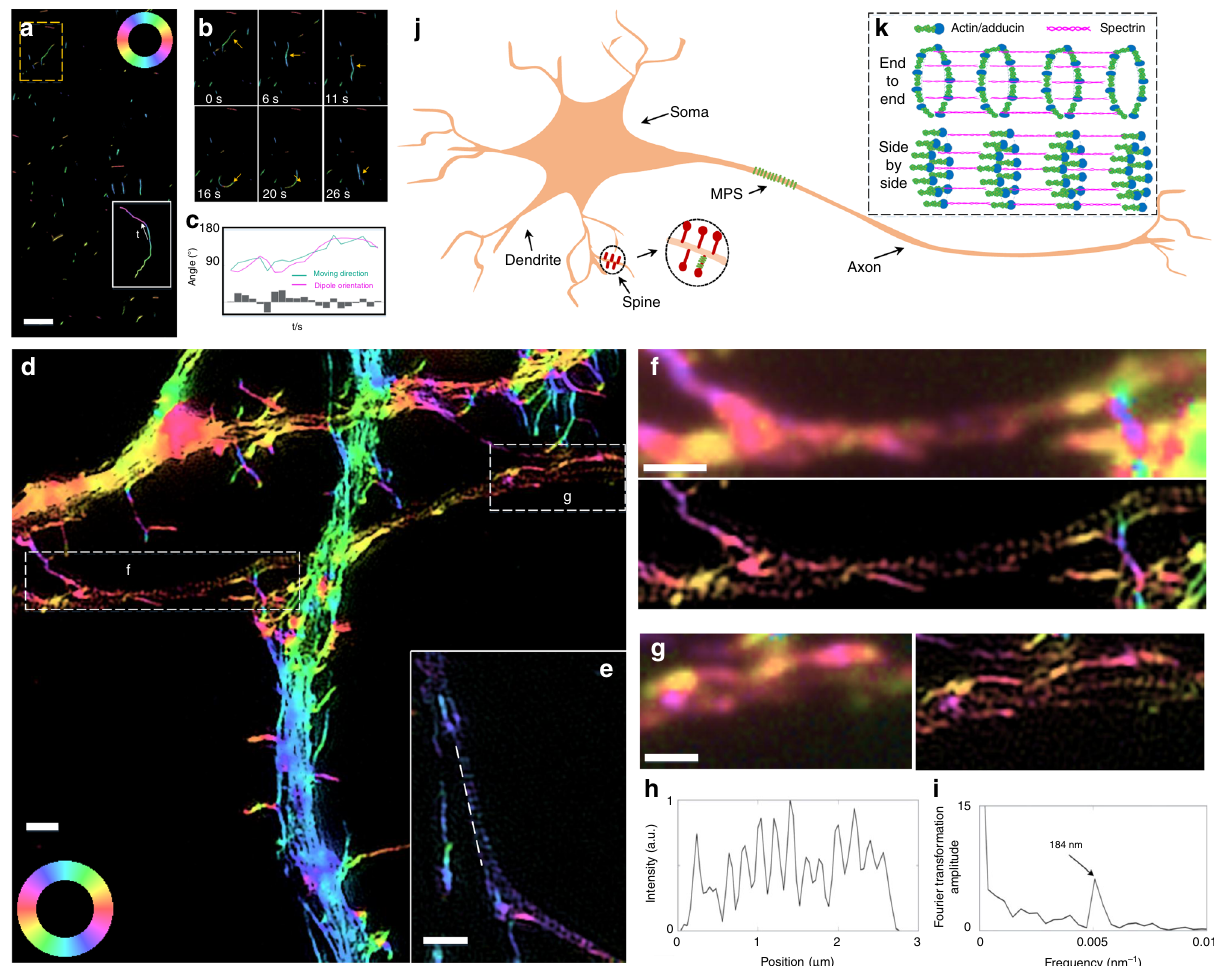
Fig. 4 Imaging the orientation of short actin fi laments. a Dynamic imaging of the myosin-driven movement of phalloidin-labeled actin fi lament. The white box contains the trajectory of a short actin fi lament. b Magni fi ed view of the yellow boxed region in a . The dipole orientations of the actin fi laments change as they move. c Time-lapse orientation and position of the fragmented actin in b . d 2D-pSIM imaging of the actin fi laments in hippocampal neurons, which clearly distinguishes between the continuous long actin fi laments in the dendrite and the region of discrete actin ring structure in the axon. e Another illustration of the actin ring structure in the axon. f , g Magni fi ed views of the boxed regions in d , which compare the results of PM and pSIM imaging. h The intensity pro fi le of the line indicated in e , whose Fourier transform ( i ) shows a 184 nm periodicity, consistent with previously reported results. j , k The actin ring structure is critical to the membrane-associated periodic skeleton (MPS) in neurons. The previous model assumes an end-to-end organization for the adducin-capped actin fi laments. However, pSIM reveals that the orientation of the short actin fi laments is parallel to the axon shaft, supporting a side-by- side organization for the actin ring structures. Scale bars: a 2 μ m and d – g 1 μ